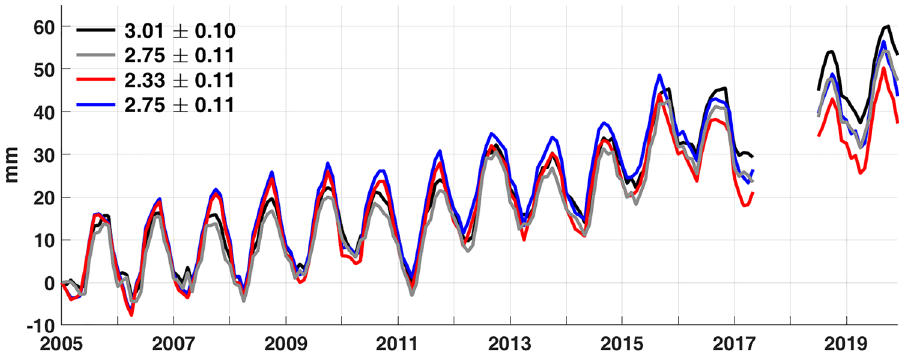
Figure 1. GMOM SAL from GRACE/GFO (red and blue) and GMOM A-A from Altimeter-Argo (black and gray). The black line is based upon an ensemble average of Argo data including both thermosteric and halosteric contributions. The gray line is similar to the black but only includes a thermosteric contribution. Red and blue lines were based on GIA models of Peltier et al. 17 and Caron et al. 20 , respectively. Numbers are associated linear trends with 95% confidence intervals.